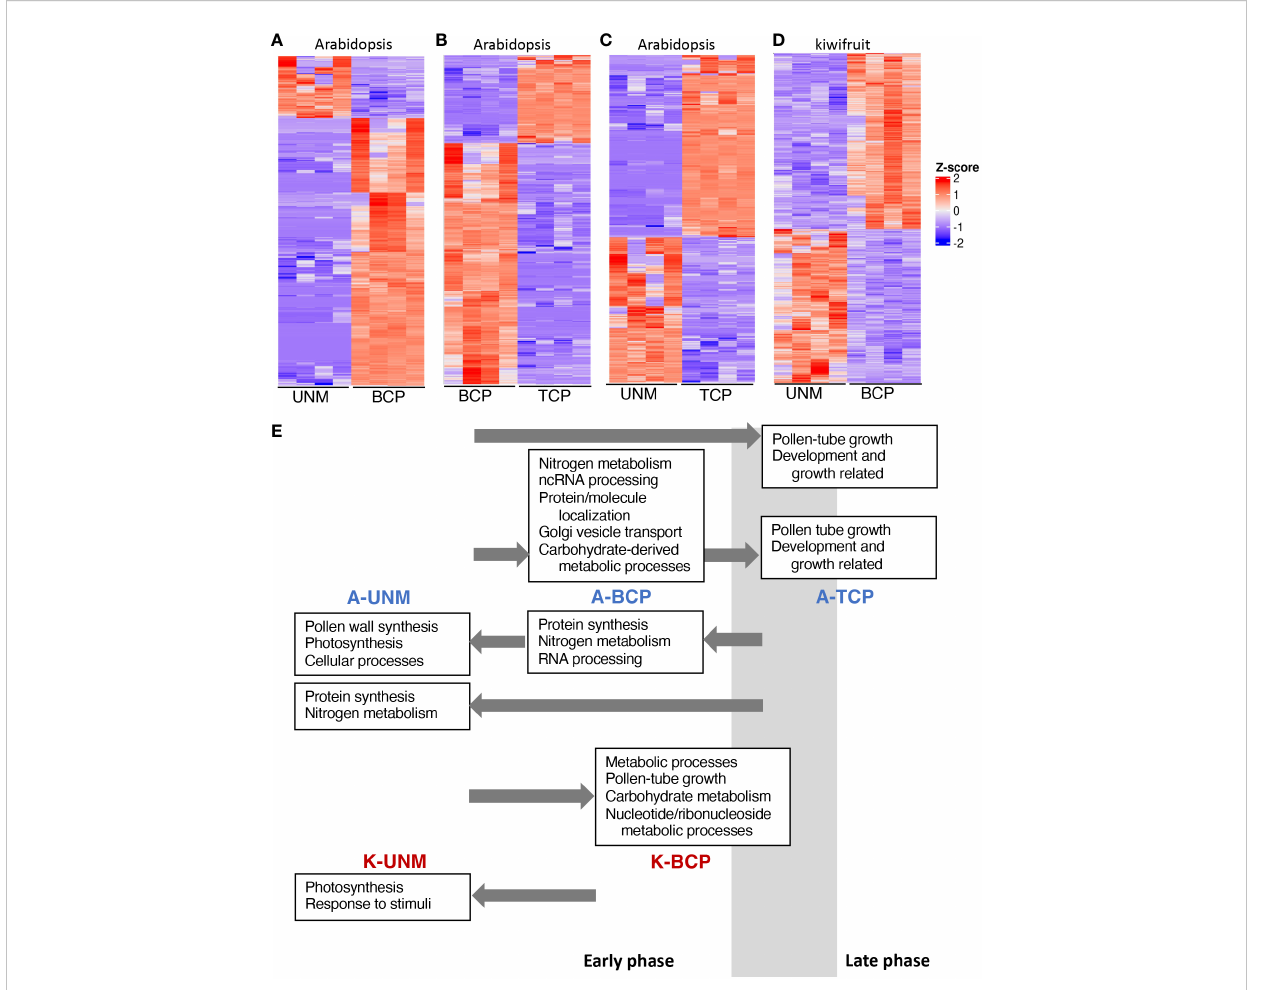
FIGURE 4 Differential gene expression between pollen stages. (A – D) Heatmaps showing differentially expressed genes between the UNM and BCP stages of Arabidopsis (A) , the BCP and TCP stages of Arabidopsis (B) , the UNM and TCP stages of Arabidopsis (C) , and the UNM and BCP stages of kiwifruit (D) . Z-score indicates normalized expression level. (E) Summary of GO categories enriched at the different stages of pollen development for Arabidopsis (A-UNM, A-BCP and A-TCP) and kiwifruit (K-UNM and K-BCP). Key GO categories are noted in boxes above (from an earlier stage) or below (from a later stage) the stage where they have increased expression and arrows indicate the stage they are being compared to. The estimated timing of the phase transition from the early phase to the late phase in relation to the samples sequenced using the SA RNA-Seq method is indicated by a grey